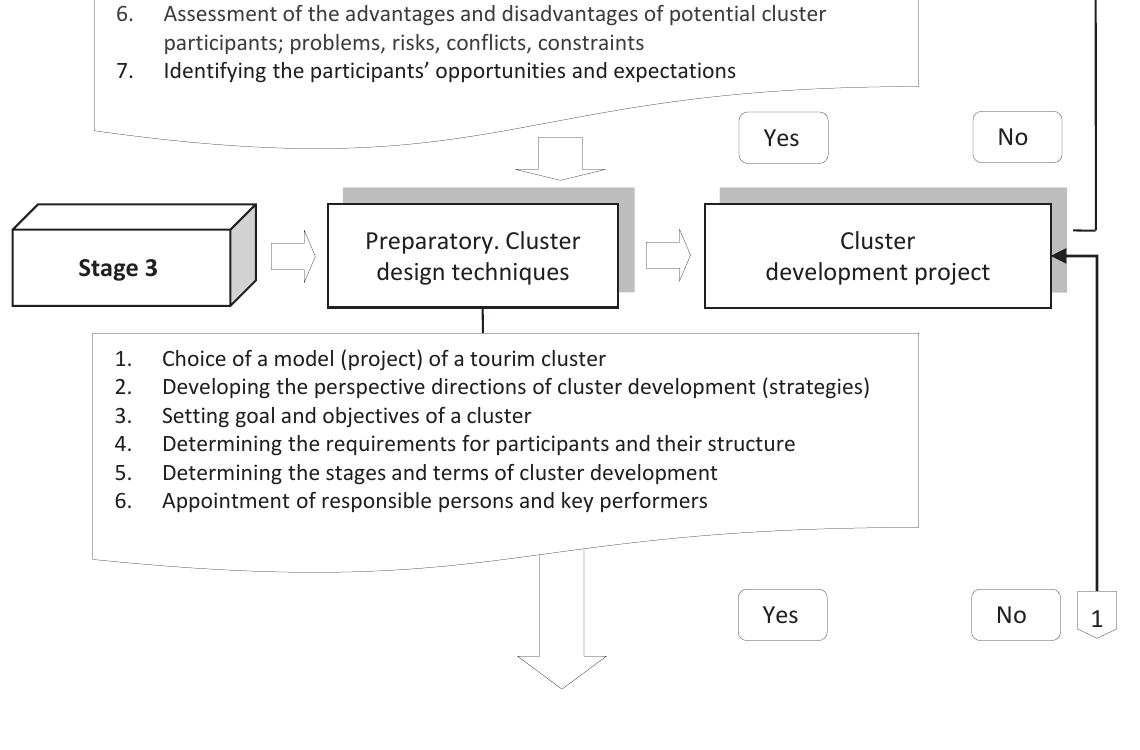
Figure 1 (beginning). Methodology of economic entities’ cluster development